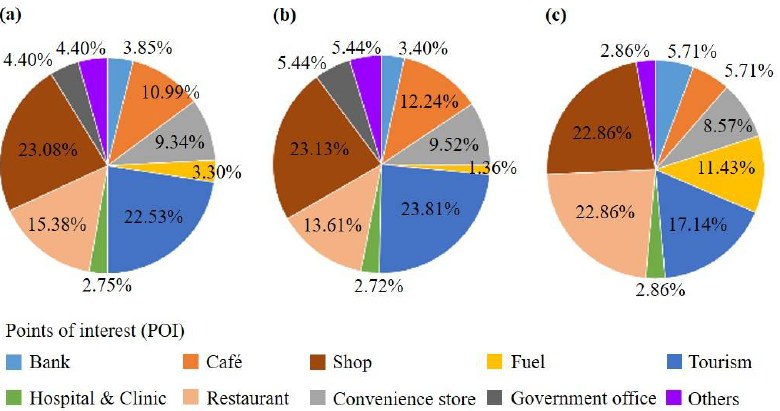
Figure 4. The ratio of each point of interest (POI) in ( a ) the study area, ( b ) the inner zone, and ( c ) the outer zone .